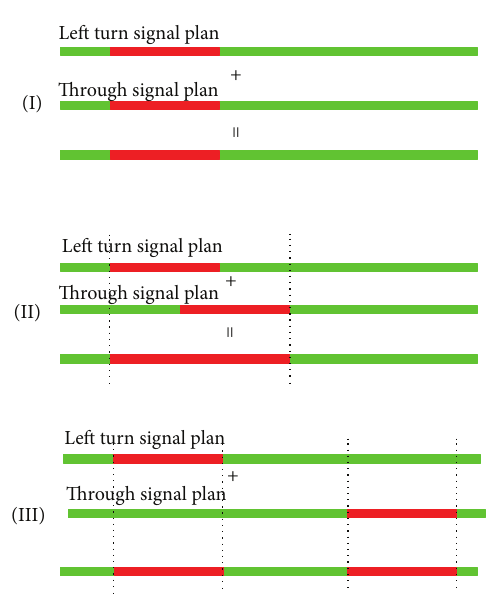
Figure 26: Virtual signal for three cases.